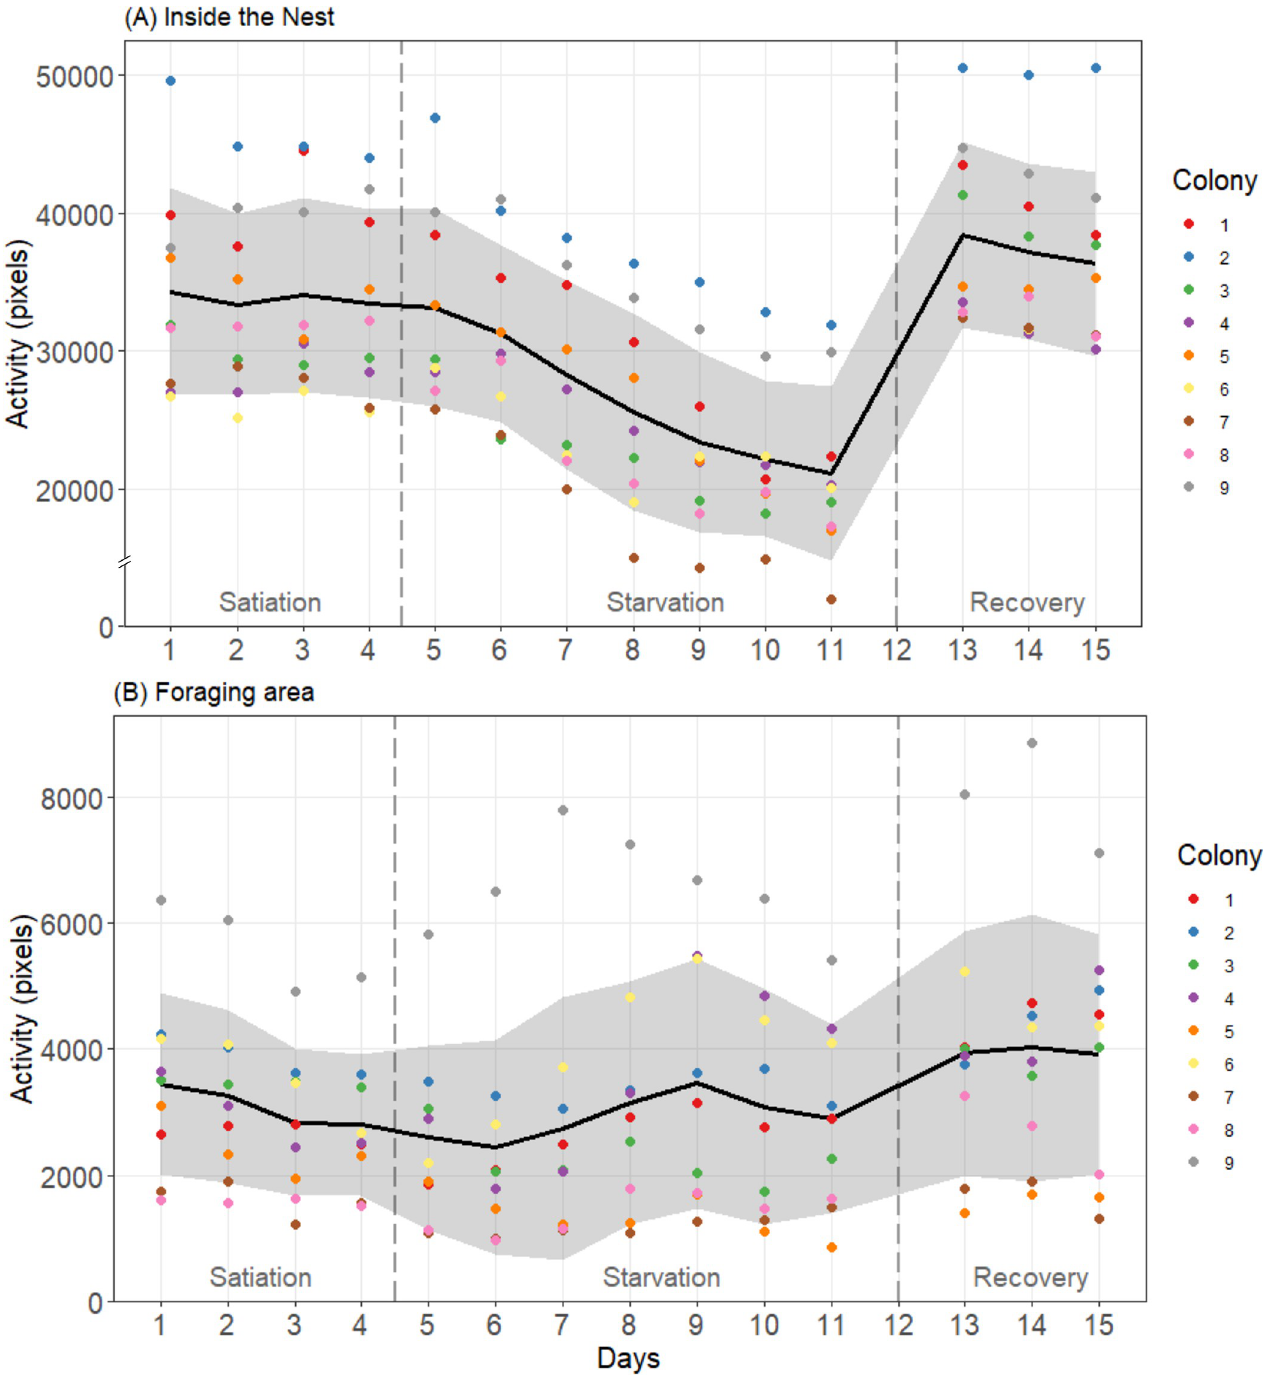
Fig 3. Time evolution of the daily indices of activity over the experimental days. Fig 3A shows the activity measured inside the nest and Fig 3B, the activity in the foraging area. The activity indices are expressed in number of moving pixels on the video recordings. Colored points are the daily activity indices measured for each of the nine tested colonies. The black line and the grey area are respectively the average value and the standard deviation calculated on the daily activity indices of the nine colonies. Food was removed on day 5 and was given back on day 12. Vertical dashed lines separate each experimental phase.